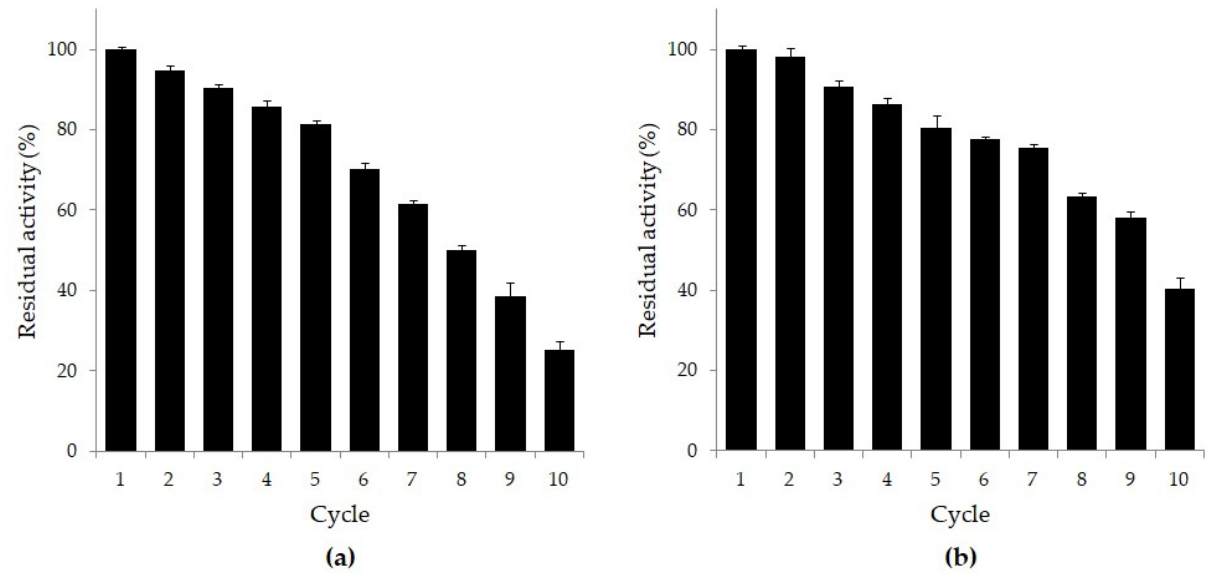
Figure 2. Reuse of ( a ) dextran coated iron oxide magnetic nanoparticles (DIOMNP) derivative of endocellulase and ( b ) Glyoxyl-agarose (GLA) derivatives of β -glucosidase in consecutive cycles of CMC hydrolysis. Reactions were carried out for 48 h in 50 mM sodium acetate buffer, pH 5.5, at 50 °C.